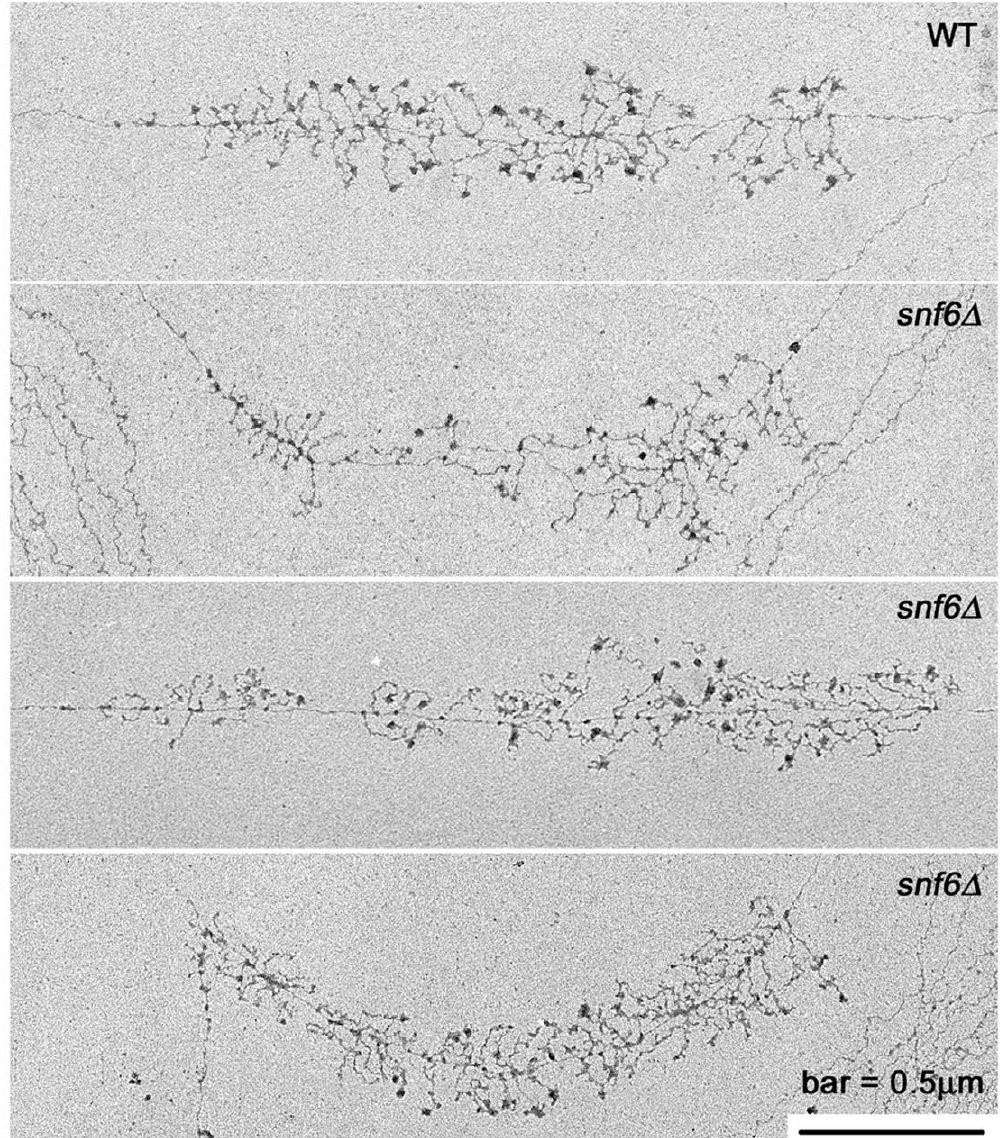
Figure 4. Miller chromatin spreads of WT and snf6 D suggest similar Pol I occupancy of rRNA genes. Direction of transcription is from left to right. rRNA transcripts per rDNA gene were quantified for these representative and many additional genes. For the genes shown, the number of rRNA transcripts was 51 for WT (DAS648), and was 44, 39, and 60 for the three snf6 D (DAS647) genes (top to bottom).